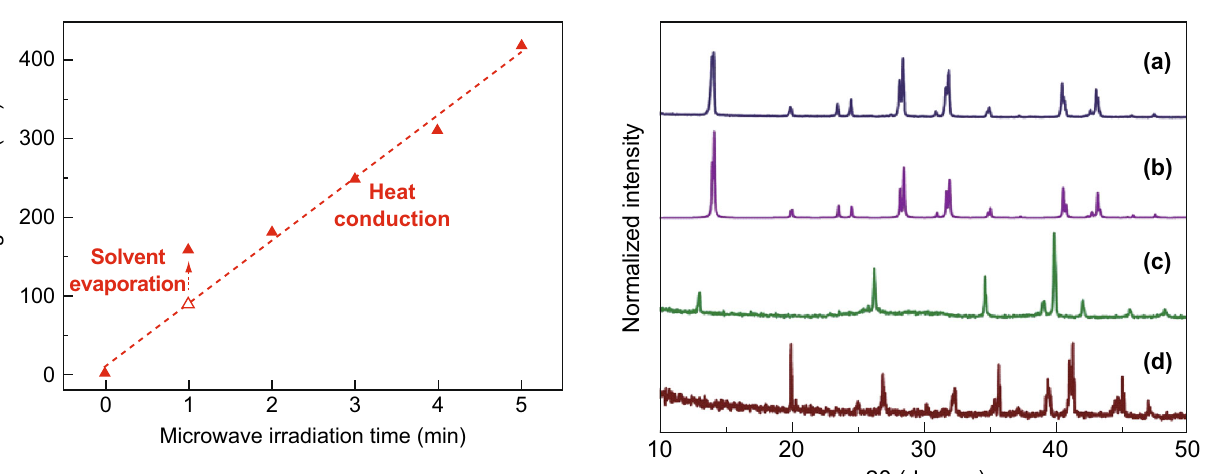
Fig. 11 Time dependency of average grain size. Reproduced with permission Ref. [27]. Copyright (cid:2) 2016 American Chemical Society